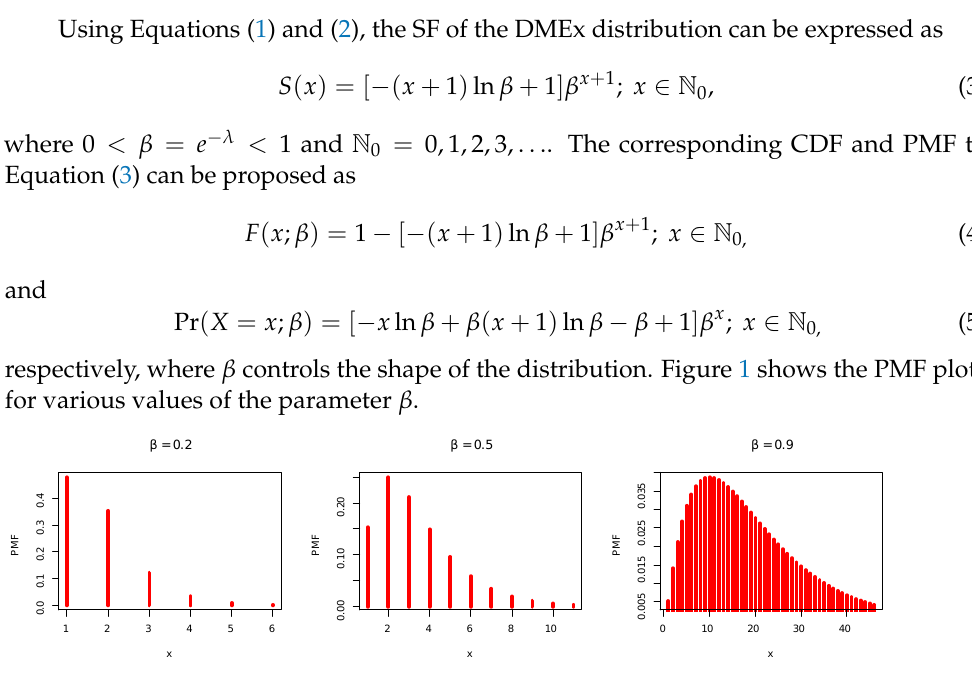
Figure 1 . PMF visualization plots for the DMEx model. Figure 1. PMF visualization plots for the DMEx